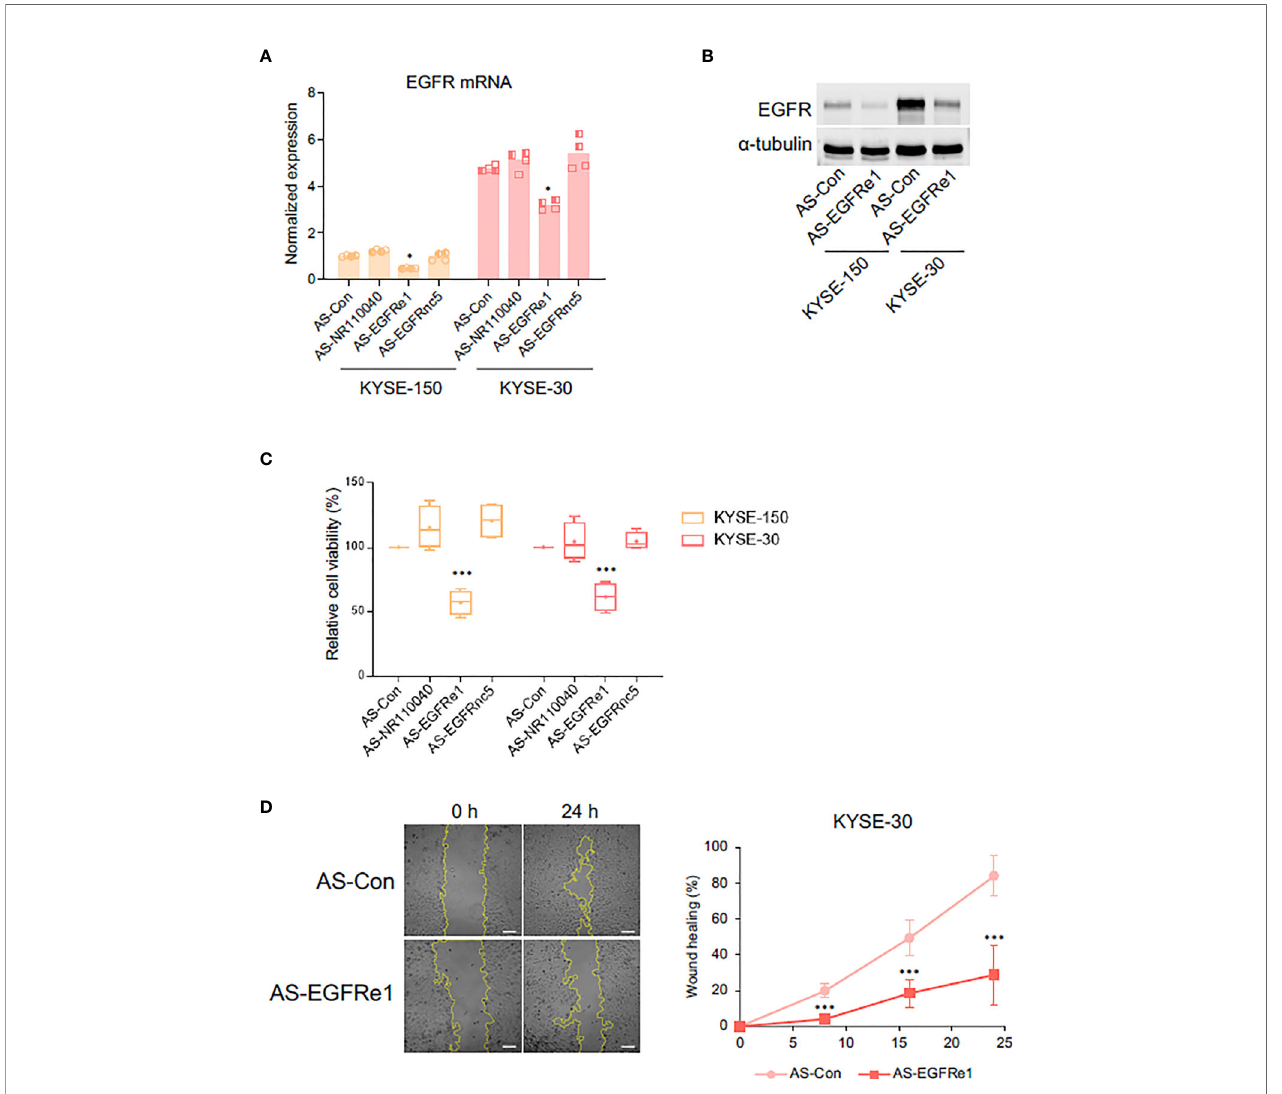
FIGURE 4 | Impact of EGFRe1, a putative enhancer RNA for EGFR, on cell proliferation and migration of KYSE-30 cells. (A) EGFR mRNA expression was examined in cells transfected with each LNA-AS targeting control or ncRNAs. Normalized expression was obtained from comparing relative expression (EGFR/Actb) in each group to that in the KYSE-150 control group. Two technical replicates from two biological replicates were displayed. * p -value < 0.05 compared to group of control LNA-AS transfection (AS-Con). (B) Representative Western blot showed that suppressing EGFRe1 reduced EGFR expression in both KYSE-150 and KYSE-30 cells. (C) Cell viability rate in each LNA-AS-transfected group was compared to the AS-Con group in each cell line. The AS-Con group was used as 100%. Box-and- whisker plots were drawn with four biological replicates, and a plus sign in each box represents the mean value. *** p -value < 0.001 compared to AS-Con in each cell line. (D) Wound healing rates in AS-Con and AS-EGFRe1 transfected KYSE-30 cells were plotted in the indicated post-wound-time points (right). Representative phase contrast images at 0 h and 24 h are displayed (left). *** p -value < 0.001 compared to AS-Con in each time